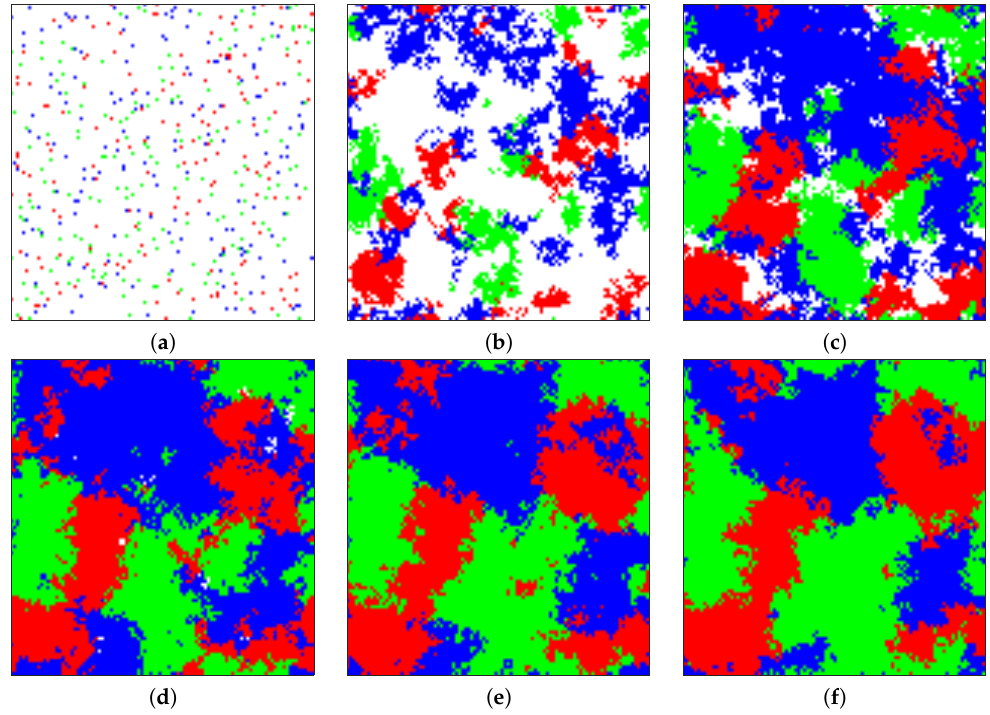
Figure 4. The evolution of the spatial game with A+, P, and C cells coexisting in equilibrium. Color code: white A − , green A+, blue P, red C. Parameters: a = b = c = d = f = 0.1, e = 0.01, g = 0.3. ( a ) Initial environment with 95% A − cells; ( b – f ) Snapshot of the environment after every 200,000